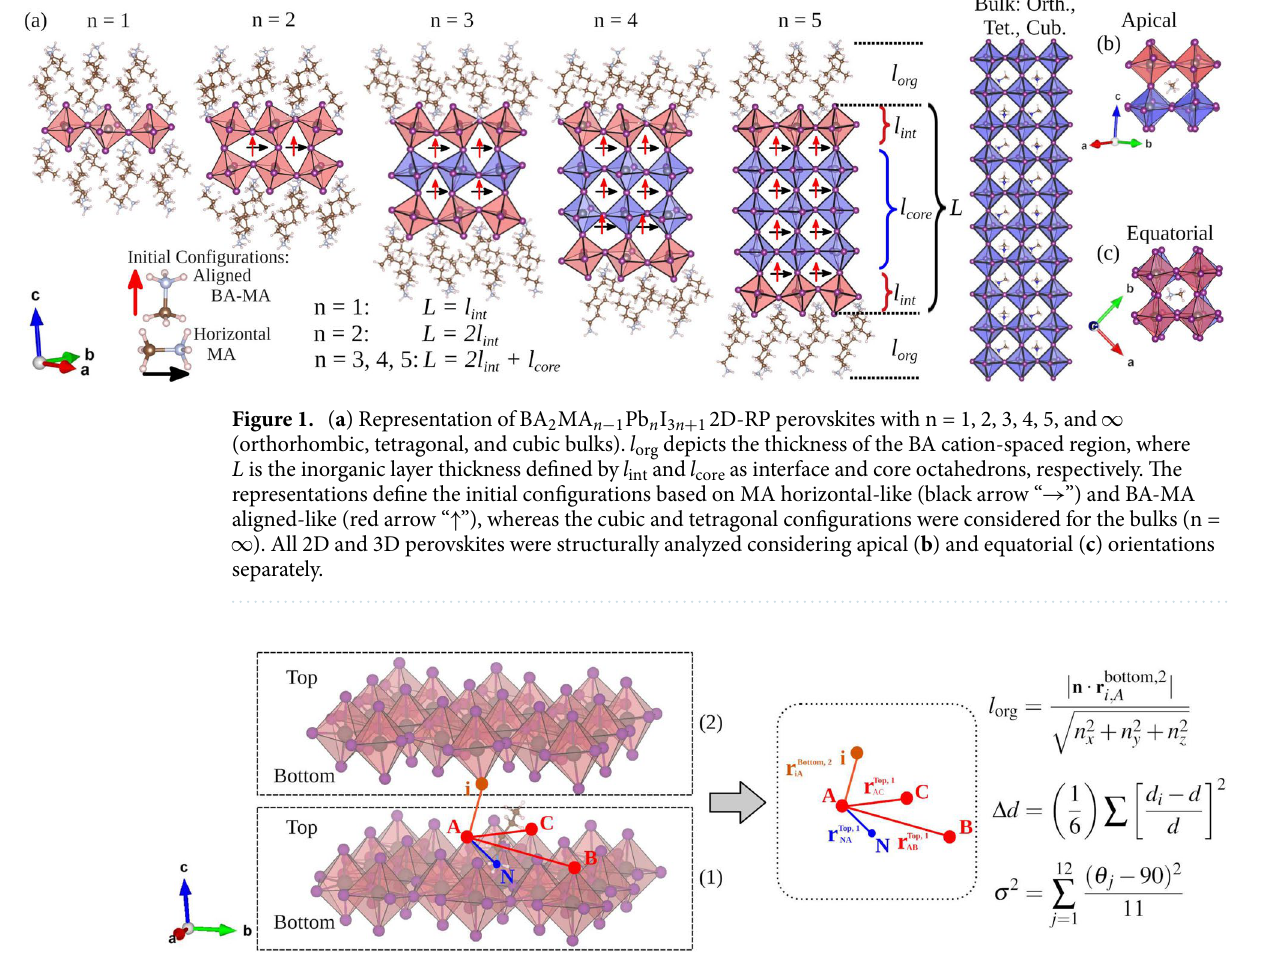
Figure 2. Inorganic layer space ( l org ) calculated through n = ( n x , n y , n z ) as the normal vector with respect to the plane formed by the apical iodine atoms in the interface region on the top of the inorganic layer, i.e., n = r top,1 r bottom,2 × r top,1 AB AC (index 1 is the inorganic layer of the plane equation). i , A is the iodine vector position on the bottom of the opposite interface region (index 2). For bond length distortion ( (cid:31) d ), d i is the individual PbI bond distance and d is the mean distance of the six PbI bond forming the octahedra. The bond angle variance ( σ 2 ) is calculated through the diference the right angle ( 90 ◦ ) and the individual I–Pb–I angles ( θ i